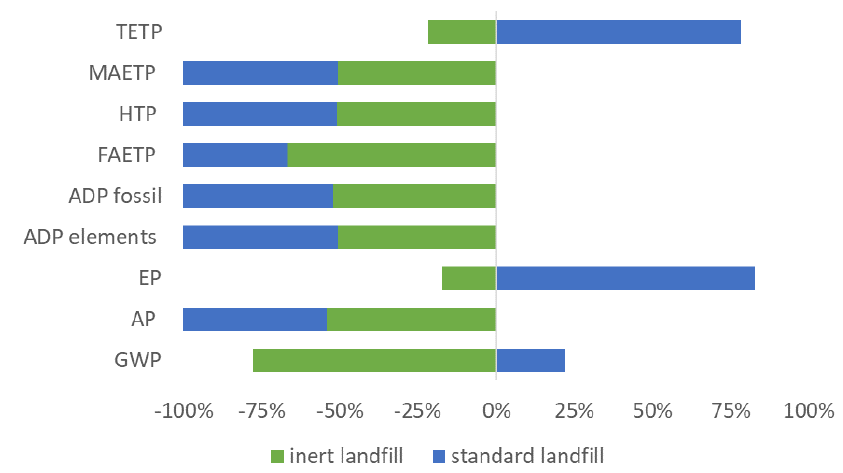
Figure 14. Landfill type effect on the environmental impact categories.